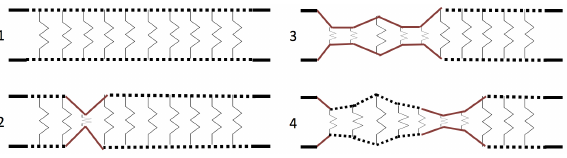
Fig. 6: Schematic of electrodynamical pumping. (1) The tube at rest; the springs connecting the top and bottom of the tube are the muscles. (2) The pacemaker initates an action potential, in which the tube will contract based on the magnitude of the signal (3)-(4) The action potential propagates along the tube, induing contraction.